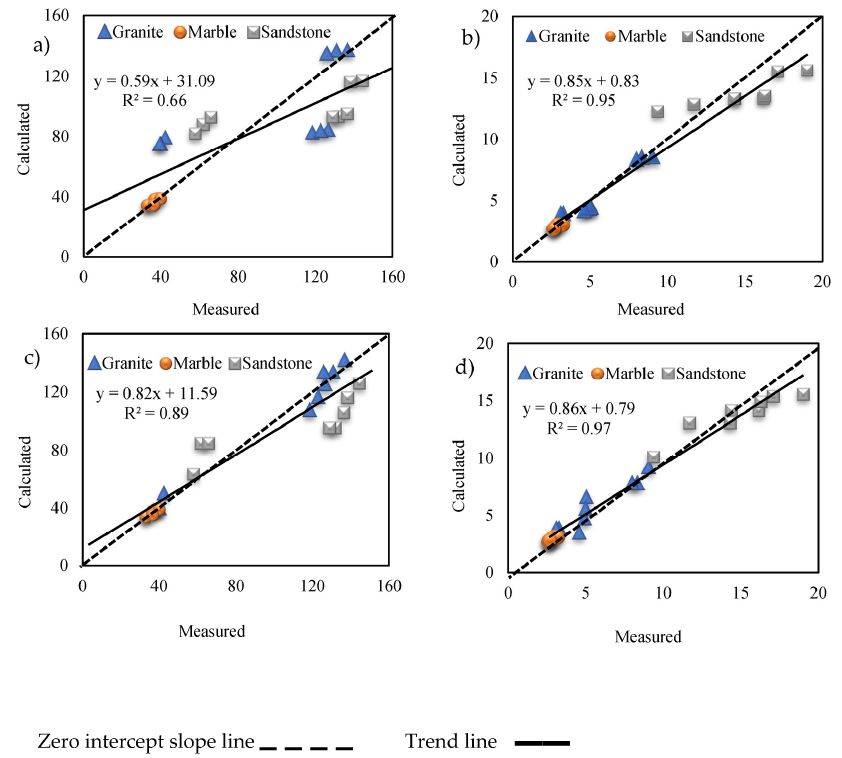
Figure 11. Measured and calculated values of strength properties of the studied rocks obtained from UPV dry ( a ) UCS MPa from UPVdry ( b ) UTS MPA from UPVdry ( c ) UCS MPa from R-value ( d ) UTS MPA from R-value. Table 9. Measured and calculated values of the strength properties of the studied